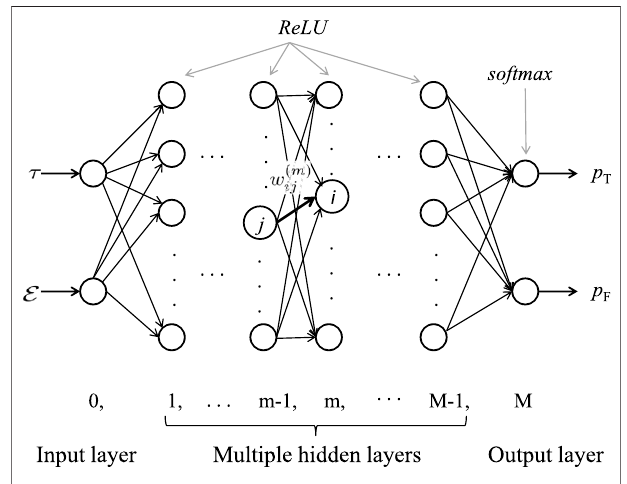
FIGURE 2 | Deep neural network